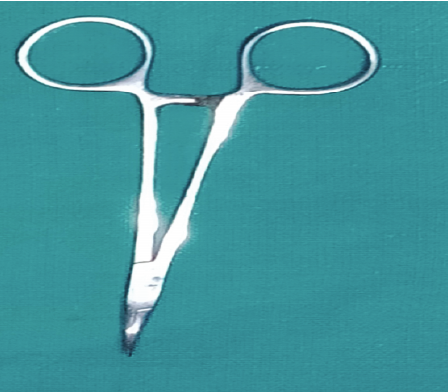
Figure 3 : vas dissecting forceps.